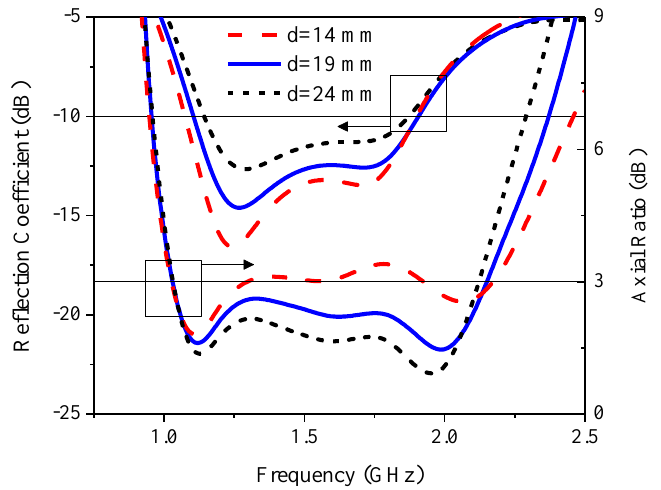
Figure 16. The simulated reflection coefficient and axial ratio under variable distance between the radiating patch and the edge of the substrate ( d ).